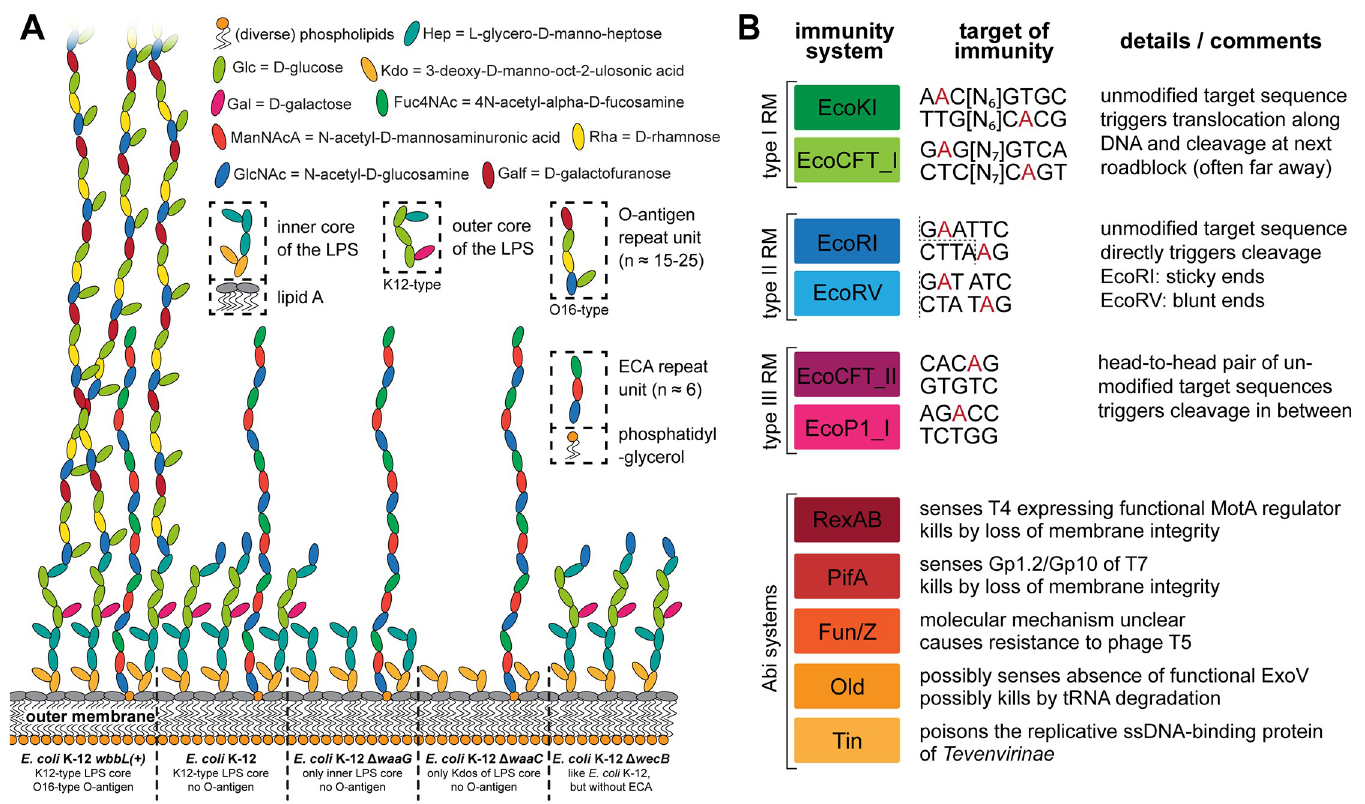
Fig 2. Overview of E . coli surface glycan variants and the immunity systems used in this study. (A) The surface glycans of different E . coli K-12 MG1655 variants are shown schematically (details in running text and Materials and methods). Note that the E . coli K-12 MG1655 laboratory wild type does not merely display the K12-type core LPS (classical rough LPS phenotype) but also the most proximal D-glucose of the O16-type O-antigen. (B) Key features of the 6 RM systems (each 2 of type I, type II, and type III) and the 5 Abi systems used for the phenotyping of this study are summarized schematically. Recognition sites of RM systems have either been determined experimentally or were predicted in REBASE (red nucleotides: methylation sites; dotted lines: cleavage sites) [45–47,129]. The Abi systems have been characterized to very different extent but constitute the most well-understood representatives of these immunity systems of E . coli [10,48].Abi, abortive infection; ECA, enterobacterial common antigen; LPS, lipopolysaccharide; RM,